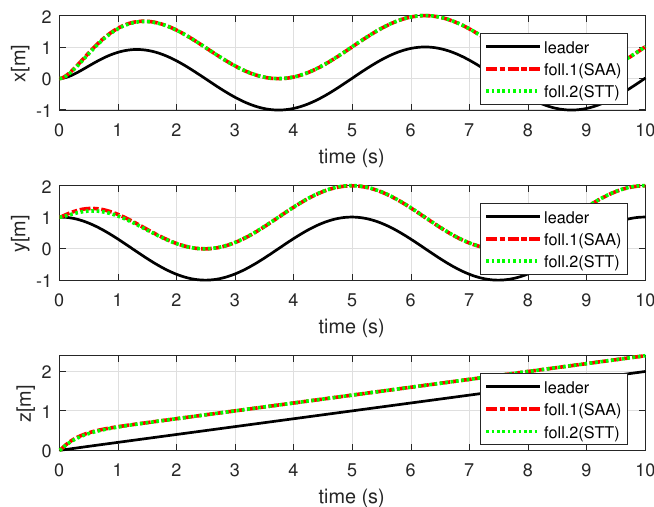
Figure 14. The results of the comparison simulation for the formation control of quadrotors about the 4 π circular trajectory: the red dashed line is the result of the backstepping-based formation control with small angle assumption (SAA), and the green dashed line is the result of the proposed formation control with the state transformation technique (STT).